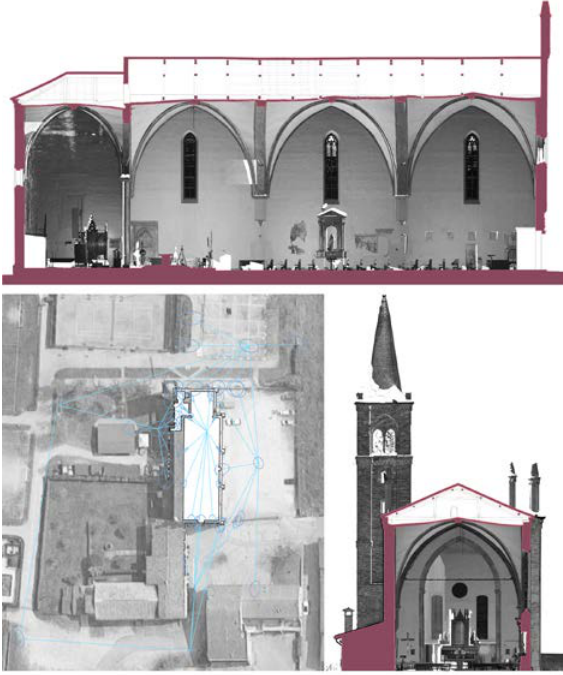
Figure 3. Example of survey of case 1 building. In particular: Chiesa degli Angeli. Above the longitudinal section with the quasi orthophoto on the background. Below, on the left the topographic network, on the right a cross section with the bell